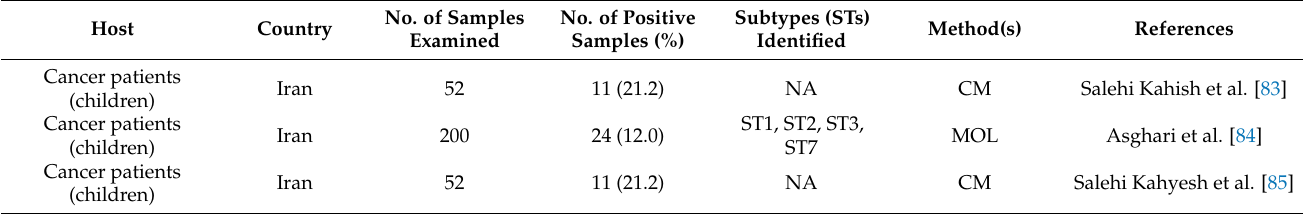
Table 2. Prevalence and subtype distribution of Blastocystis spp. in immunocompromised individuals in Asia (2010–2021). Host